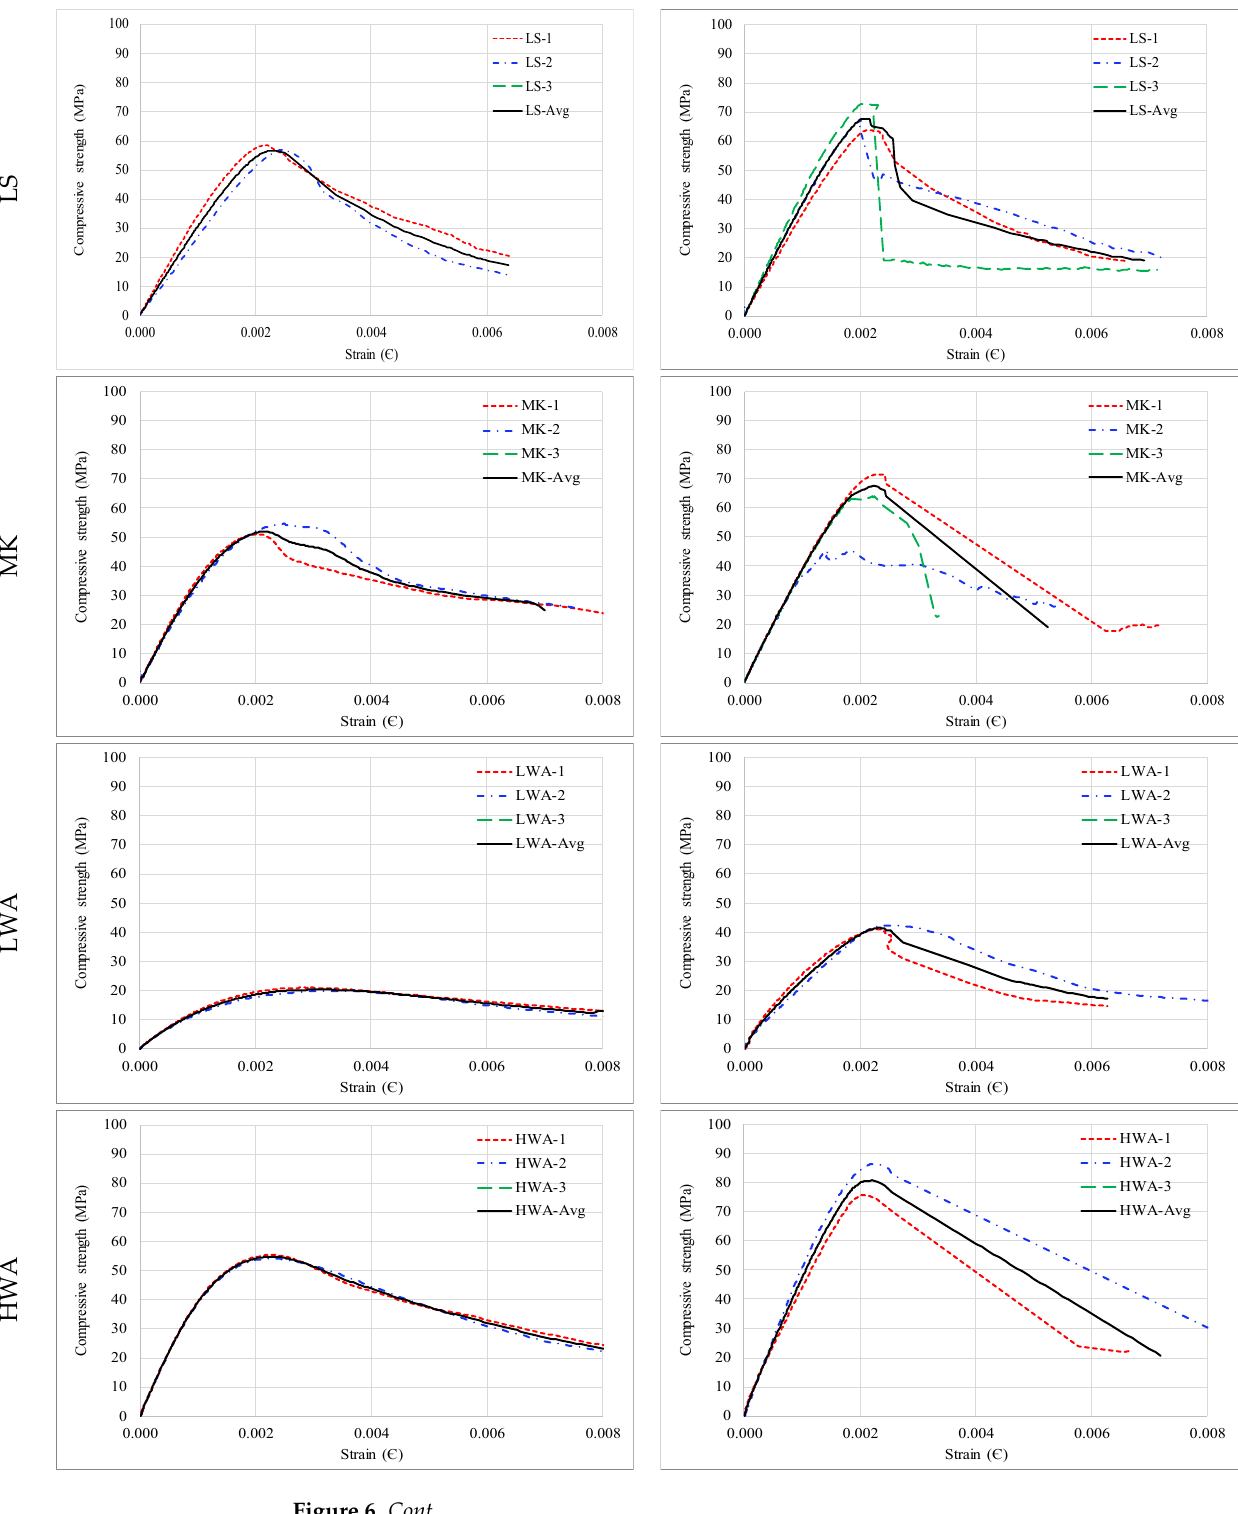
Figure 6. Stress–strain variation for: ( a ) Mix 1; and ( b ) Mix 2. Figure 6. Cont